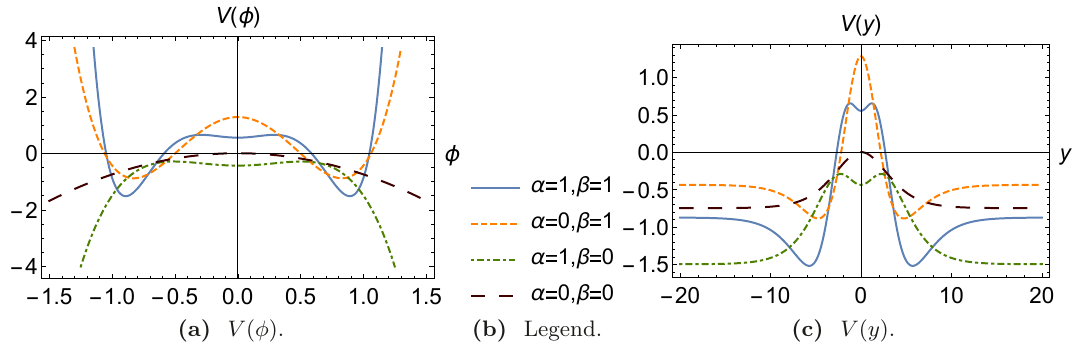
Figure 2. Plots of V ( φ ) and V ( y ) in eq. (4.6b) for f ( R, φ, X ) = (1+ αφ 2 )( R + βR 2 )+ K ( X ) The legend of the parameters α and β is given in figure 2b. The parameters are set to k = 0 . 25, v = 1, c = 0, and n =